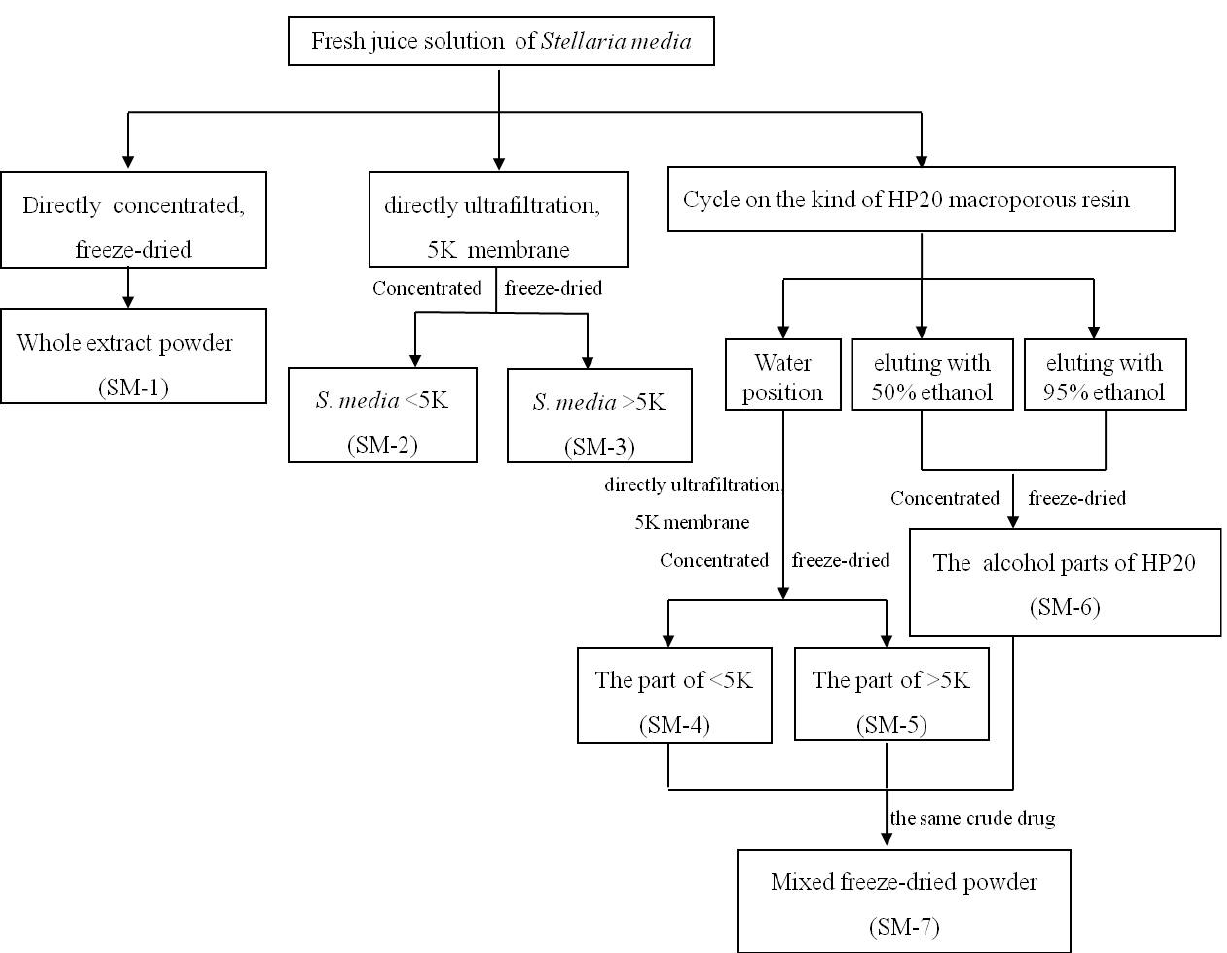
Figure 9. Flow chart of the preparation of the seven samples by different